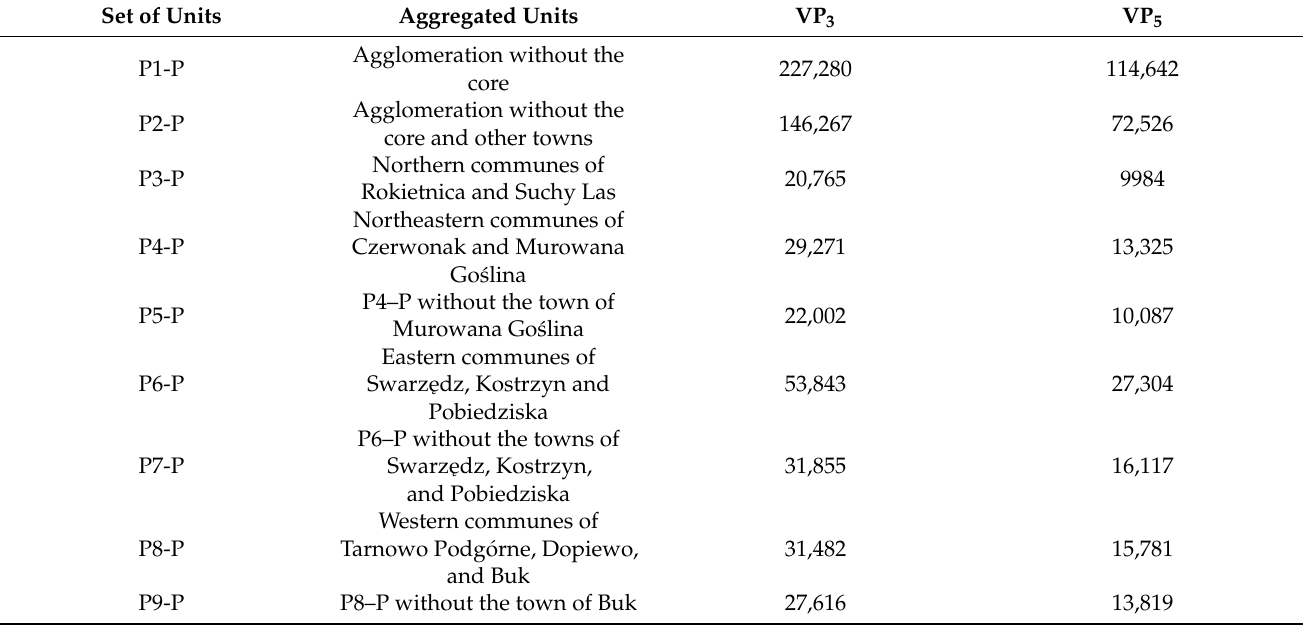
10 percentage points. One of these pairs correlated with a chosen direction (set of com- munes, including a town) with appropriate inlets (including one with big traffic intensity); the second pair also included a town, but without a big traffic inlet. Table 15. Groups aggregating demographic parameters (VP 3 , VP 5 ) within administrative units for the Pozna´n agglomeration in the year 2013.